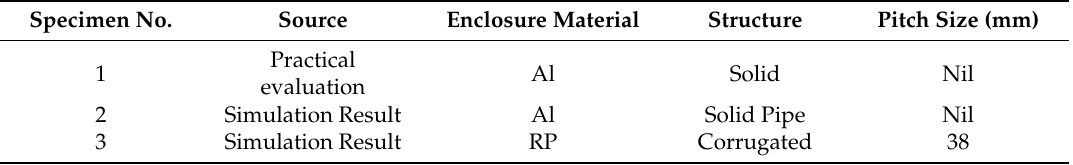
Table 1. Detailed specification of GIL specimens used for field utilization comparison.